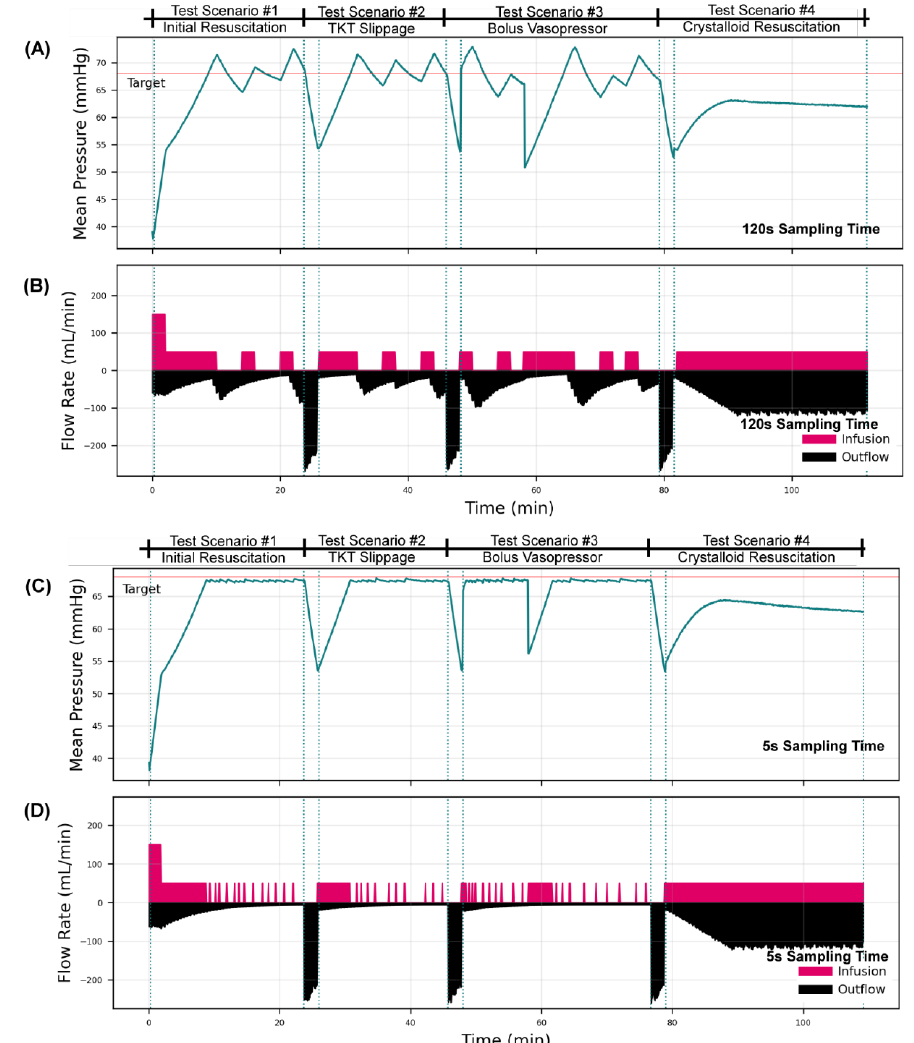
Figure 6. Decision Table Resuscitation Controller Performance with a high hemorrhage rate in the automated hemorrhage test platform. Testing results are shown for a decision table controller configured with ( A , B ) a 120 s sampling rate and ( C , D ) a 5 s sampling rate for receiving pressure signals and sending infusion pump rate commands. Results are shown for ( A , C ) the mean pressure of the system and ( B , D ) the infusion and outflow (hemorrhage + urine flow rates) of the system. The overall testing scheme was broken up into four scenarios, which begin at the first dotted vertical lines and end at the next dotted line, repeated for each scenario. The scenarios were as follows: (i) an initial hemorrhage to decrease MAP to 40 mmHg, with ongoing hemorrhage clotting over time; (ii) a severe and rapid loss of blood, mimicking tourniquet failure; (iii) similar rapid blood loss followed by bolus vasopressor delivery lasting for 10 min; and (iv) rapid blood loss with a non-clotting hemorrhage and resuscitation with crystalloid. High bleed corresponds to a faster initial bleed rate in the first phase and to continuous bleed in phase four. See HATRC Experimental Setup and Hemorrhage Test Scenarios methods for more information on the bleed logic and testing